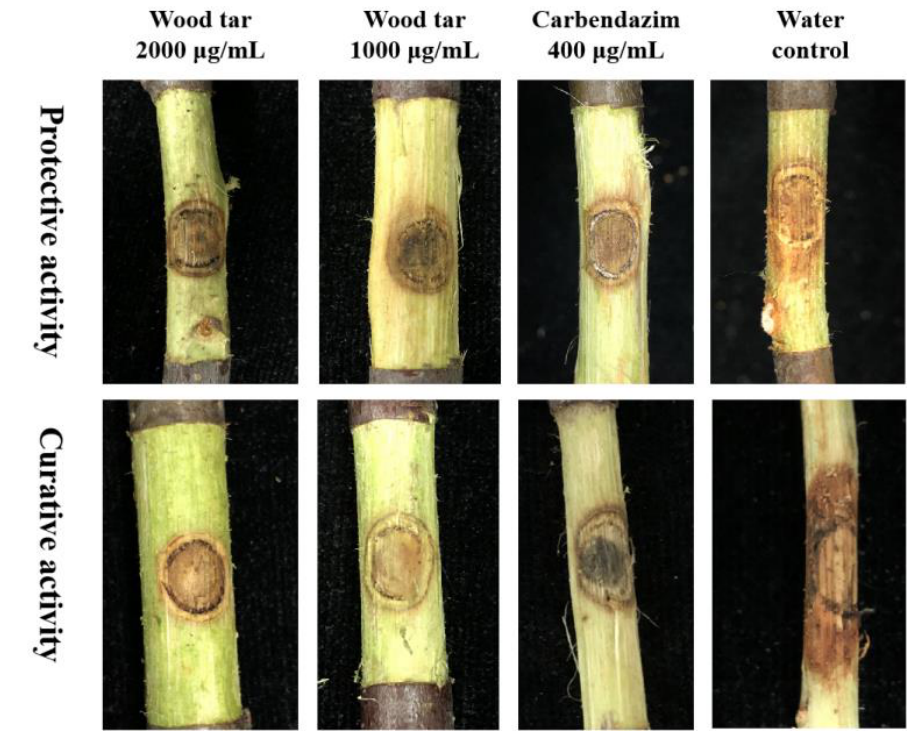
Figure 6. Protective and curative activity of wood tar against Valsa canker.